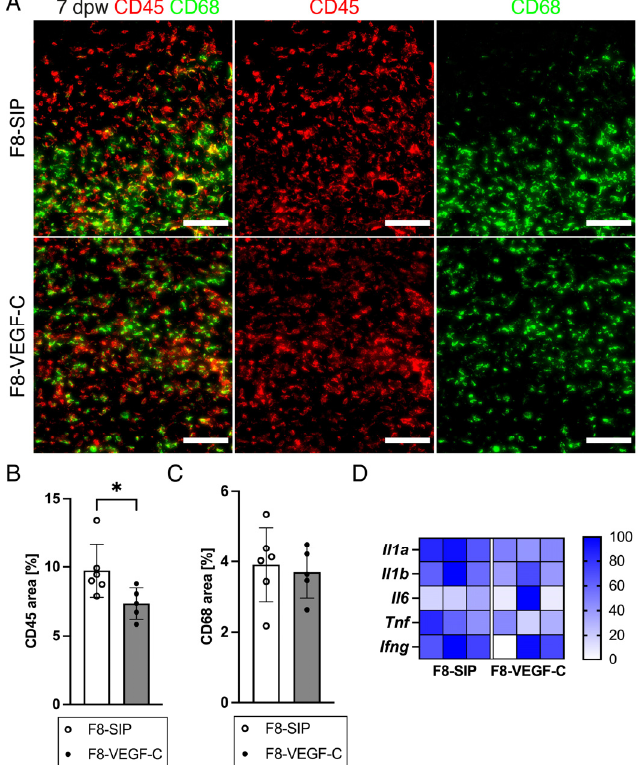
Figure 7. Targeted delivery of VEGF-C reduces immune cell density in diabetic wounds. ( A ) Repre- sentative images of CD45 and CD68 stained sections of F8-SIP- and F8–VEGF-C-treated db/db mice at 7 dpw. Scale bars: 200 µ m. ( B ) CD45+ area [%] quantified in the GT at 7 dpw. The CD45 area was significantly decreased in the wounds of F8–VEGF-C-treated mice. ( C ) CD68+ area [%] quantified in the GT at 7 dpw. The CD68 area was comparable between the two treatment groups. ( D ) Relative gene expression of selected inflammatory genes from GSEA. Gene expression is displayed as a percentage of the expression level of the sample with the highest value for each gene. N = 9–11 wounds of 5–6 mice per group. Scale: 0–100%. Students t -test, p < 0.05